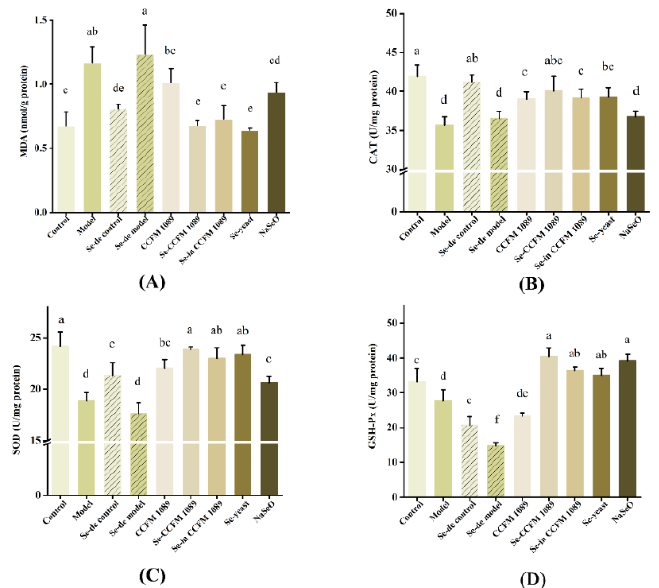
Figure 6. Effects of different Se products on the activity of oxidative enzymes in colon. ( A ) Malon dialdehyde (MDA) levels; ( B ) Catalase (CAT) levels; ( C ) Superoxide dismutase (SOD) levels; ( D ) Glutathione peroxidase (GSH-Px) levels. Graphs show mean ± SD; n = 5. Significant differ- ences are indicated by different superscript letters ( p < 0.05), and the same superscript letters above the bars indicate that the differences between the values are not statistically significant ( p > 0.05).